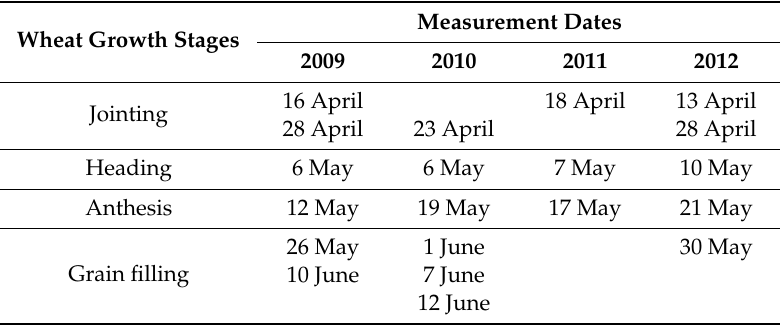
Table 2. Spectral reflectance measurement dates for 2009, 2010, 2011, and